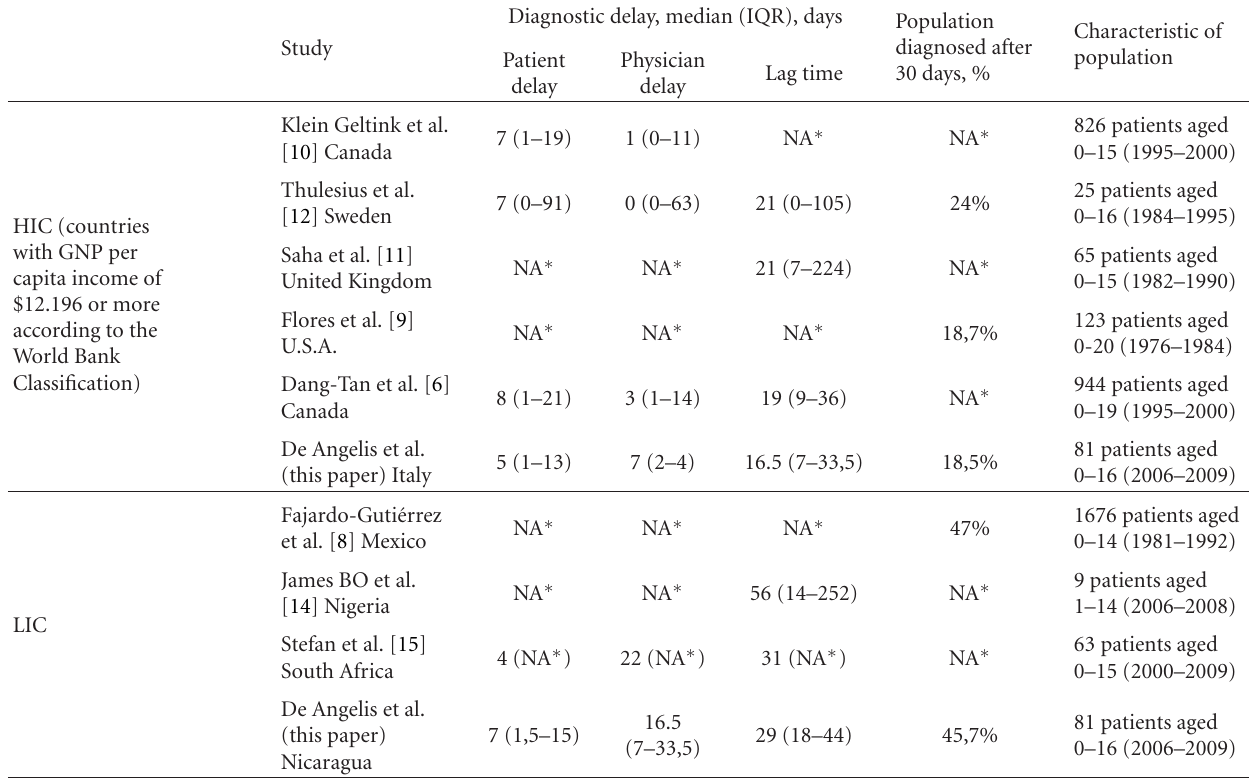
Table 3: Literature notes about studies dealing with lag time from first symptoms to diagnosis in childhood leukemia.